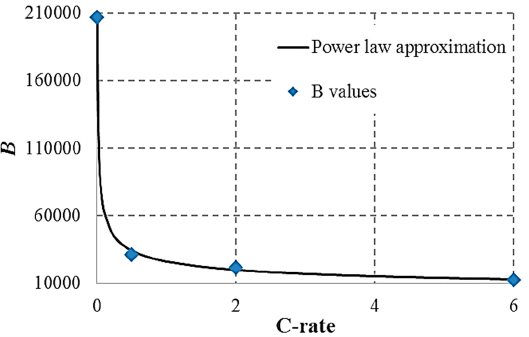
Table 3. B values used to calculate the C-rate vs. B power law approximation and obtained by Equation (5).